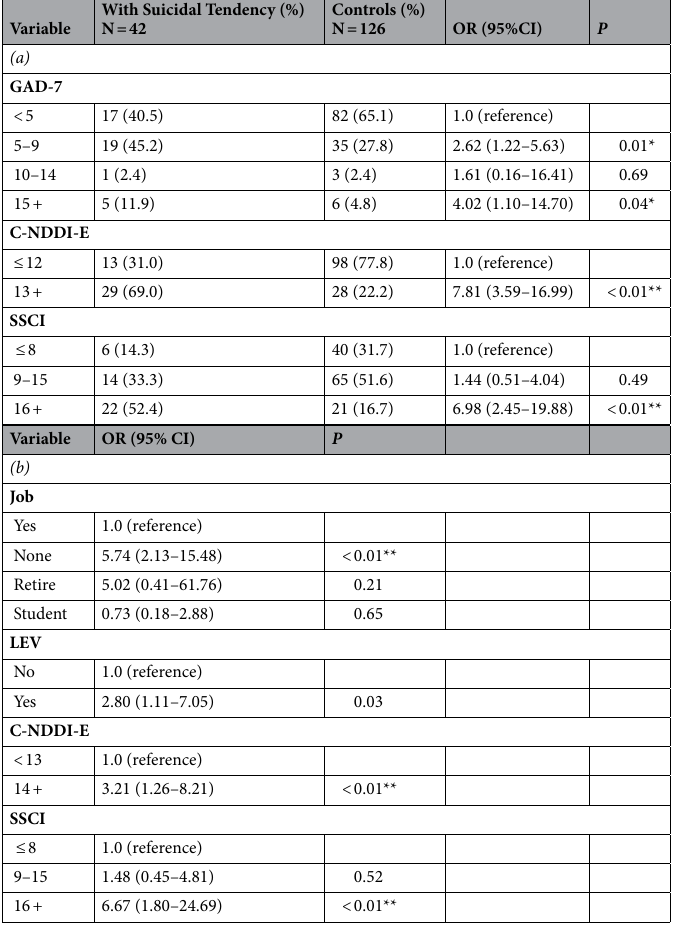
Table 4. (a) Comparison of GAD-7, C-NDDI-E and SSCI between PWE with high suicidal risk and PWE without (using univariable regression) (b) Multivariate conditional logistic regression analysis of association factors for suicidal tendency. GAD-7 seven-item anxiety scale, C-NDDI-E Chinese version of the Neurological Disorders Depression Inventory for Epilepsy, SSCI-8 The Stigma Scale for Chronic Illnesses 8-item version, LEV levetiracetam, CI confidence interval, CI confidence interval, OR odds ratio. * P < 0.05; ** P <